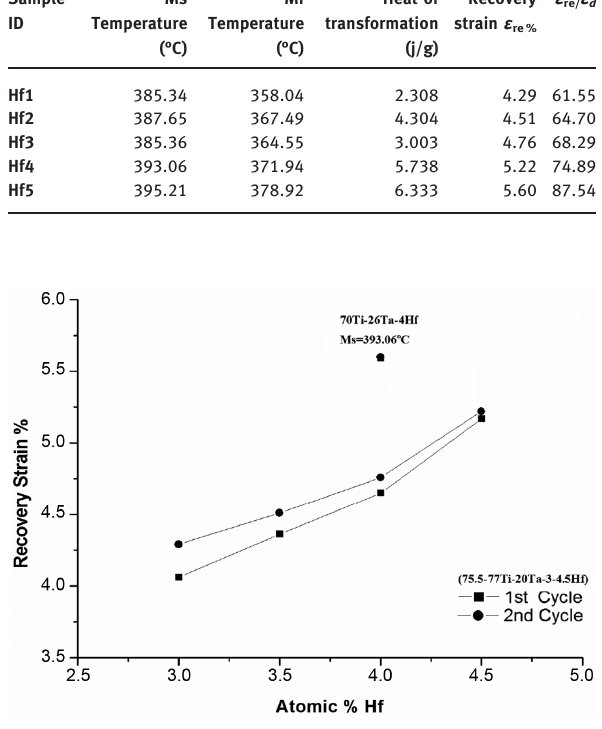
Figure 6: Effect of Hf and Ta content on strain recovery during two training cycles of samples after